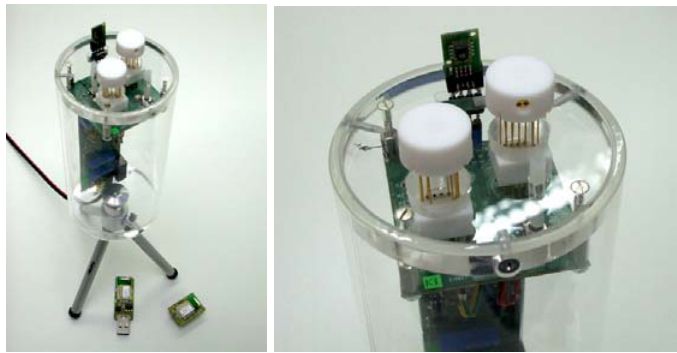
Figure 6. Images of the sensing unit. Blue socket hosts the wireless communication module, appearing at the base of the unit together with its USB wireless router, to be connected to the router